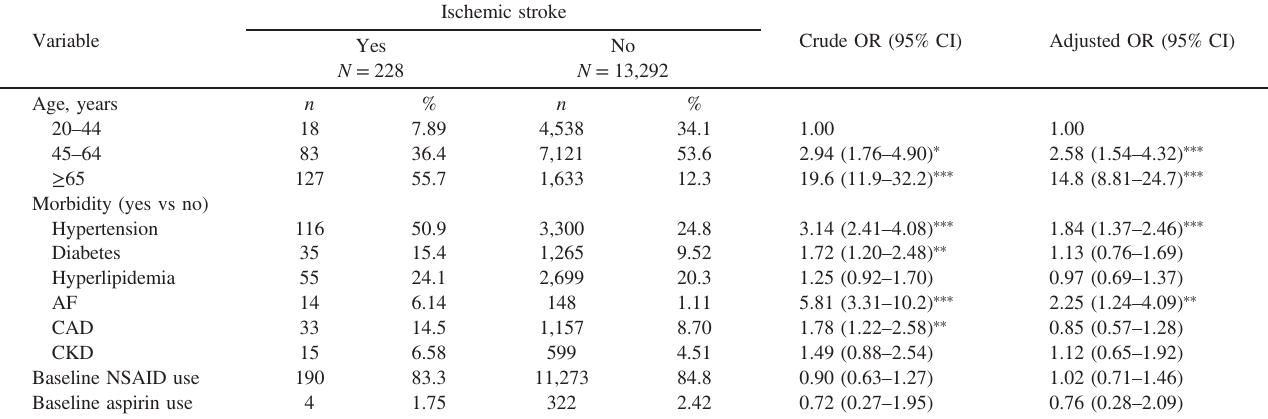
Table 3. Nested case-control analysis of ischemic stroke in osteoarthritis cohort